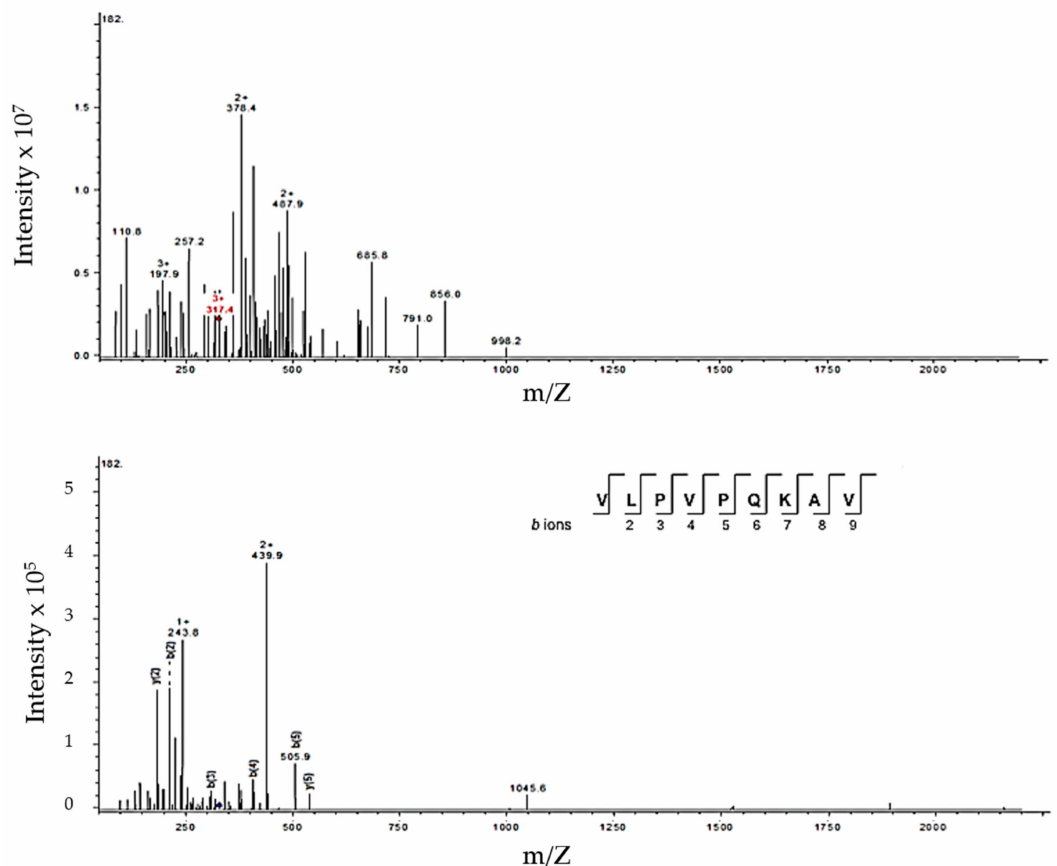
Figure 8. Typical mass spectrum corresponding to peptide sequence (VLPVPQKAV) collected from F4 obtained from milk fermented by Lactobacillus fermentum J28. ( A ) Triple-charged ion 317.4 m / z ; ( B ) tandem mass spectrometry (MS/MS) spectrum for the specified ion in ( A ). After interpretation and comparison in the database, the fragment AA sequence matched β -CN